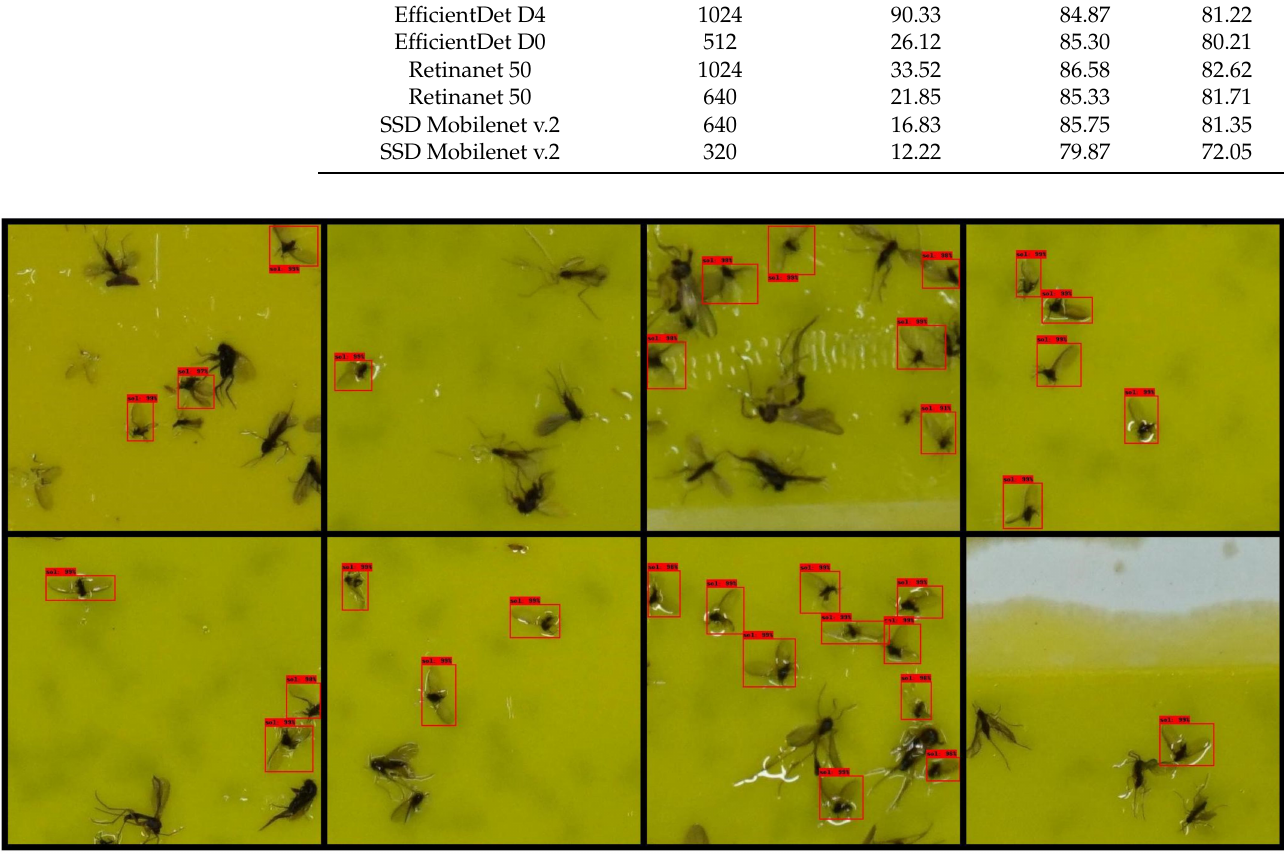
Figure 7. Detection result images of the 12 × 8 cropping condition (0.5 score